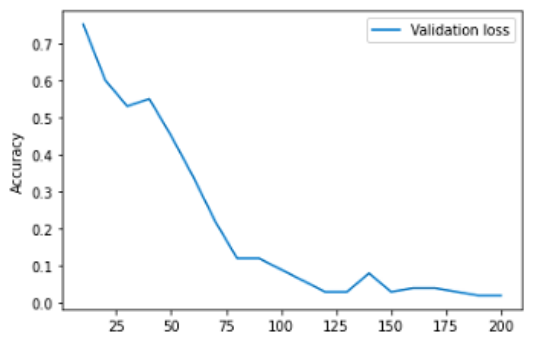
Figure 10. Training loss learning curve.